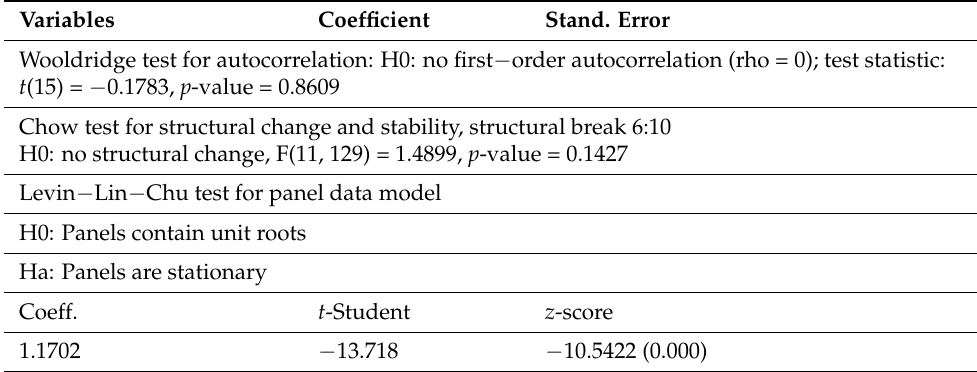
Table 4. Cont. Variables Coefficient Stand.